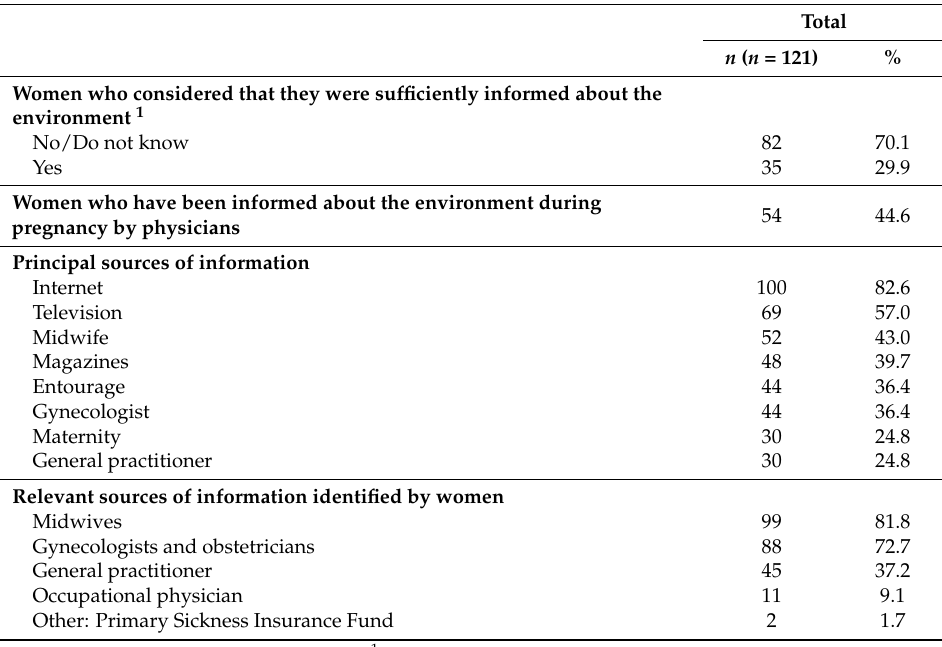
Table 6. Women’s sources of information about the environment ( n =